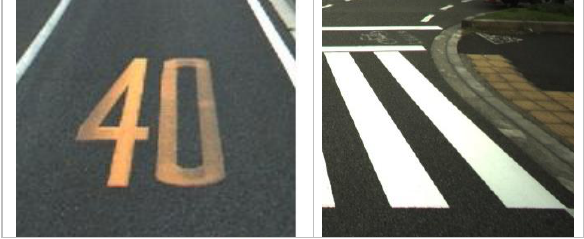
Figure 5. Typical check points for evaluation of the developed vehicle-loading system